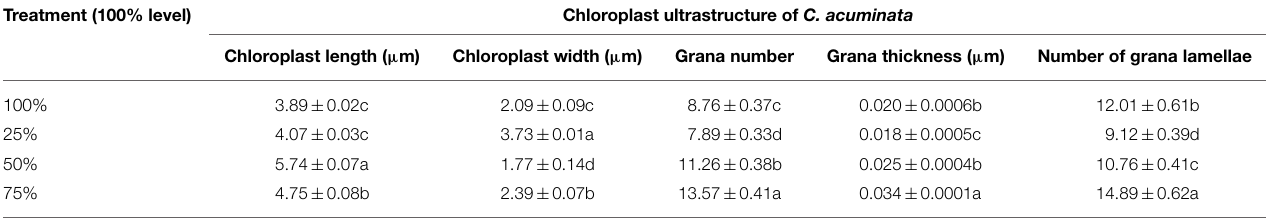
TABLE 5 | Light intensity and chloroplast ultrastructure of C. acuminata leaves. Treatment (100% level)